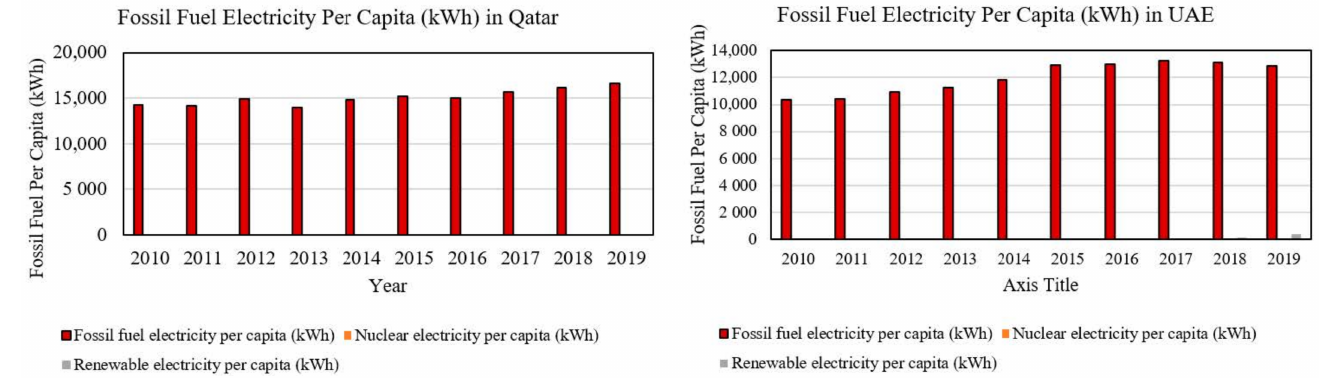
Figure 13. Fossil fuel electricity per capita (kWh) in Qatar and